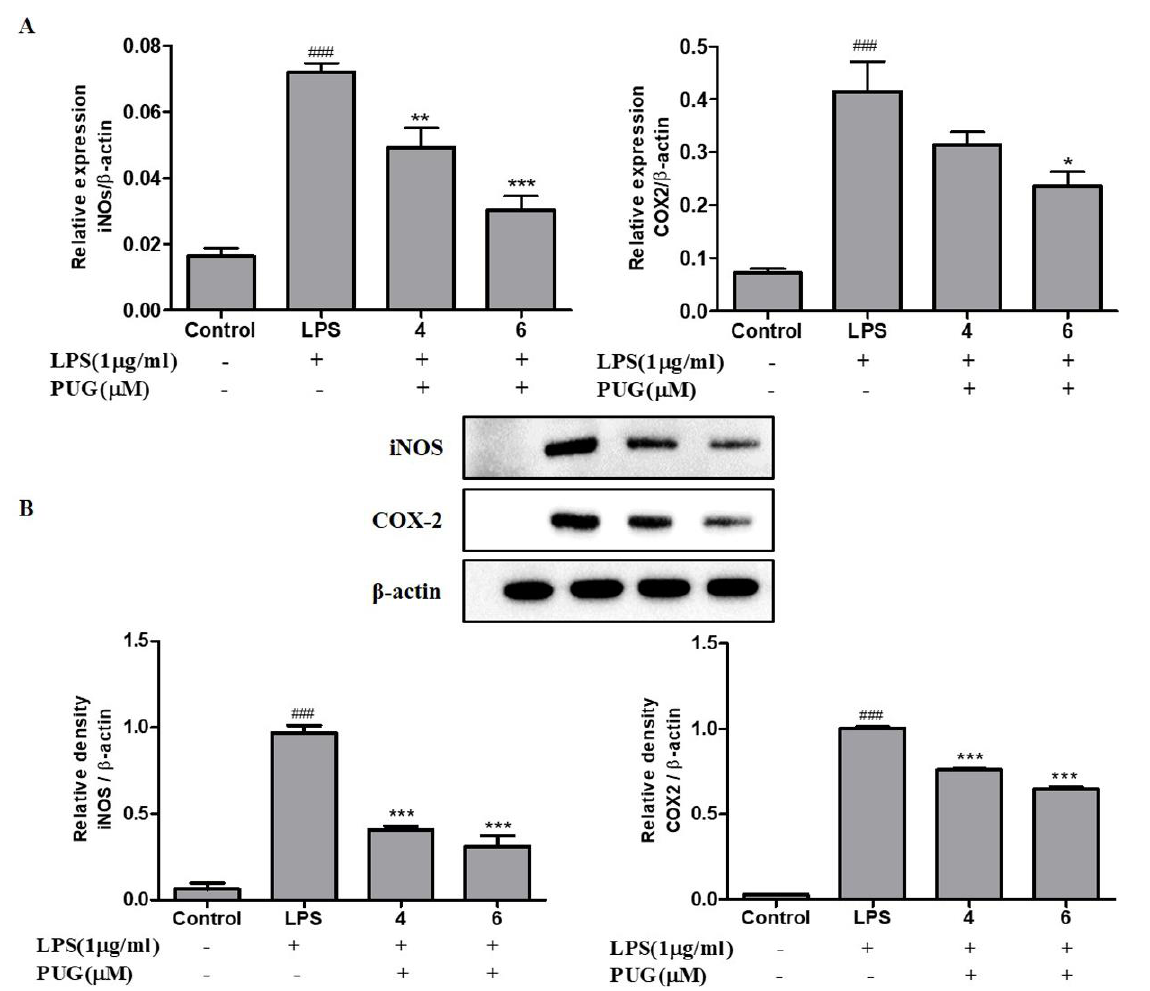
Figure 6. PUG decreases the mRNA and protein expression of pro-inflammatory cytokines COX2 and iNOS in activated RAW264.7 macrophage cells: ( A ) mRNA expression of COX2 and iNOS; ( B ) Western blot analysis of COX2 and iNOS. For mRNA expression, the RNA was isolated from the cells after treatment and converted into cDNA. The converted cDNA was used for the quantitative expression. The Cq values were used for plotting the graph by the 2 − ∆∆ Cq method. The relative expression for both genes was calculated by normalization with the β -actin gene. For protein expression, the protein was harvested from the cells and Western blotting was performed. The expression levels were calculated by the densitometry with the SEM of three independent values. The statistical significance was ### p < 0.001 vs. untreated group; and * p < 0.05, ** p < 0.01, *** p < 0.001 vs. LPS-alone treated